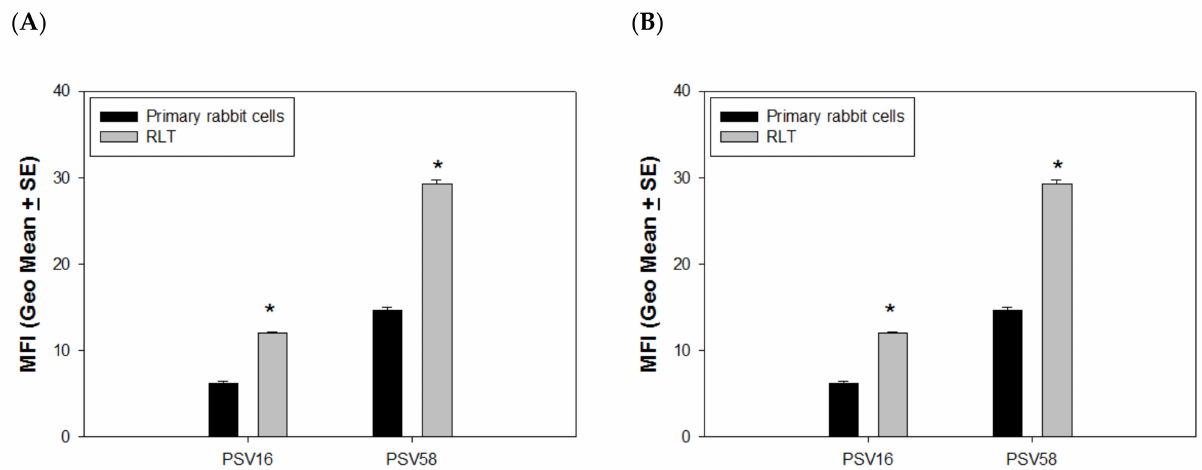
Figure 4. Delivery efficacy was determined by cell status. ( A ) Higher delivery efficacy was found in immortalized cells when compared to primary cells ( p < 0.05, unpaired Mann Whitney test, indicated by *). ( B ) Significantly higher delivery efficacy was found in PSV58 when compared with PSV16 ( p < 0.05, unpaired Mann Whitney test, indicated by *) in mouse dendritic